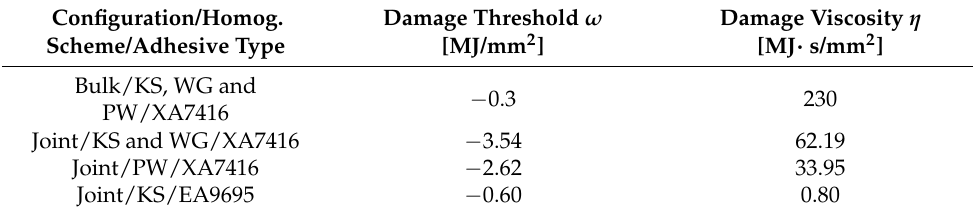
Figure 5. Torsional shear strain-stress ( γ − τ ) response of cylindrical butt-joint specimens of epoxy- based adhesive Henkel Hysol EA9695: fitting of the proposed numerical model (with Kachanov- Sevostianov scheme) to the experimental data by [36]. Table 2. Numerically estimated damage